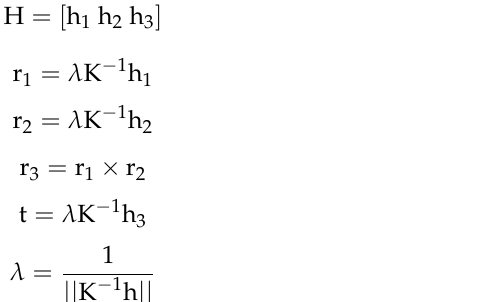
Figure 3. The layout of the planar markers ( left ) and the coordinate system used in pose estimation ( right ).